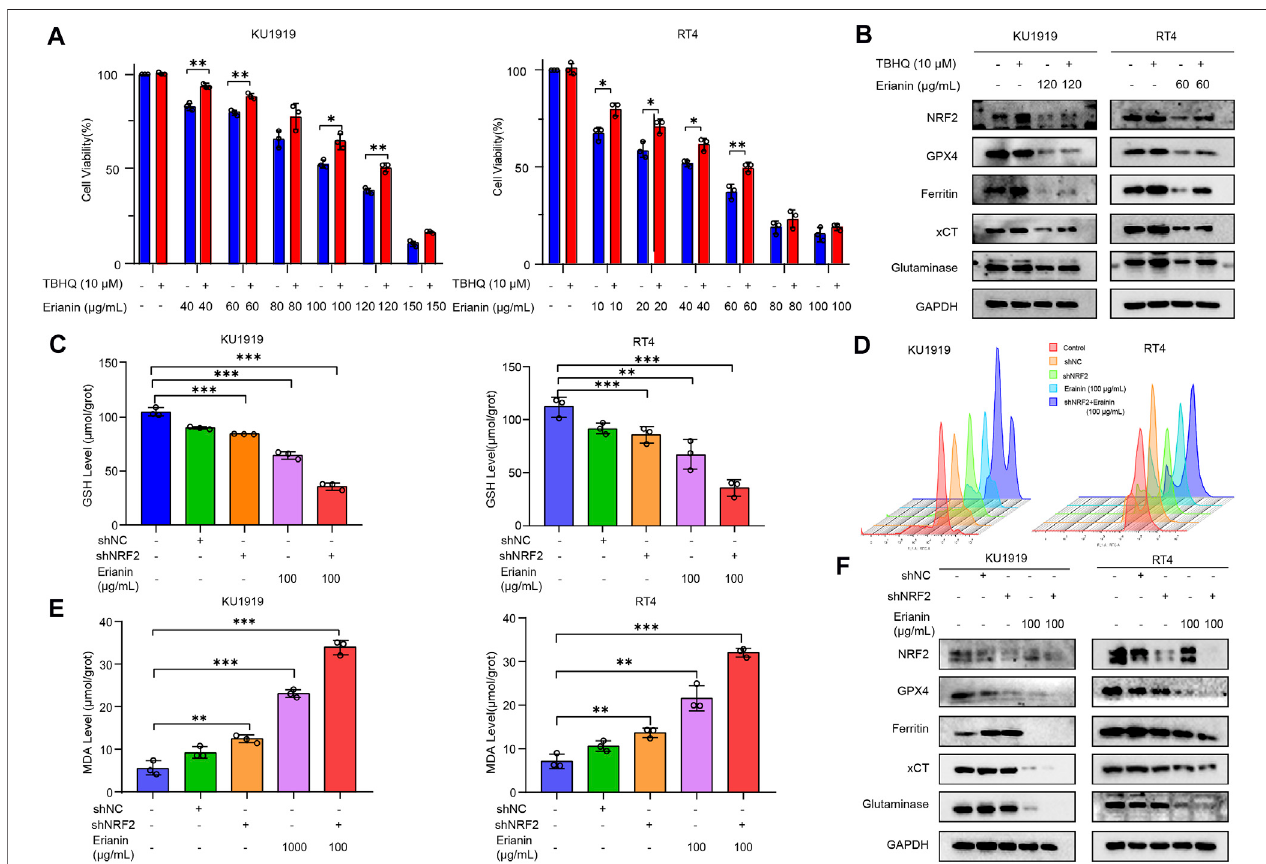
FIGURE 5 | Erianin triggered ferroptosis via the NRF2 pathway. (A) Cell viability was quanti fi ed by CCK-8 assay in KU-19 – 19 and RT4 cells treated with the combination of erianin and TBHQ. * p < 0.05,** p < 0.01. (B) The expression of NRF2, GPX4, ferritin, xCT and glutaminase was analyzed in KU-19 – 19 and RT4 cells treated with the combination of erianin and TBHQ. (C) The GSH level in KU-19 – 19 and RT4 cells was detected after the treatment with erianin and shNRF2, ** p < 0.01,*** p < 0.001. (D) The ROS level in KU-19 – 19 and RT4 cells was detected after the treatment with erianin and shNRF2, ** p < 0.01. (E) The MDA level in KU-19 – 19 and RT4 cells was detected after the treatment with erianin and shNRF2, ** p < 0.01,*** p < 0.001. (F) The expression of NRF2, GPX4, ferritin, xCT and glutaminase was analyzed in KU-19 – 19 and RT4 cells treated with erianin and shNRF2.